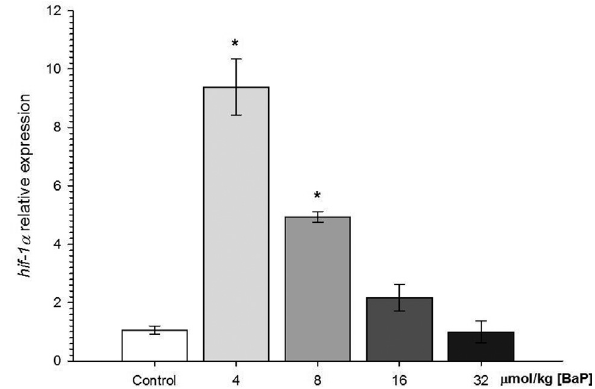
Figure 3 - Genetic damage index (GDI) of erythrocytes of C. macropomum after 96 h of injection of different concentrations of B[a]P. *Indicates significant differences compared to control group (corn oil) (p < 0.05). Kruskal-Wallis test was used.